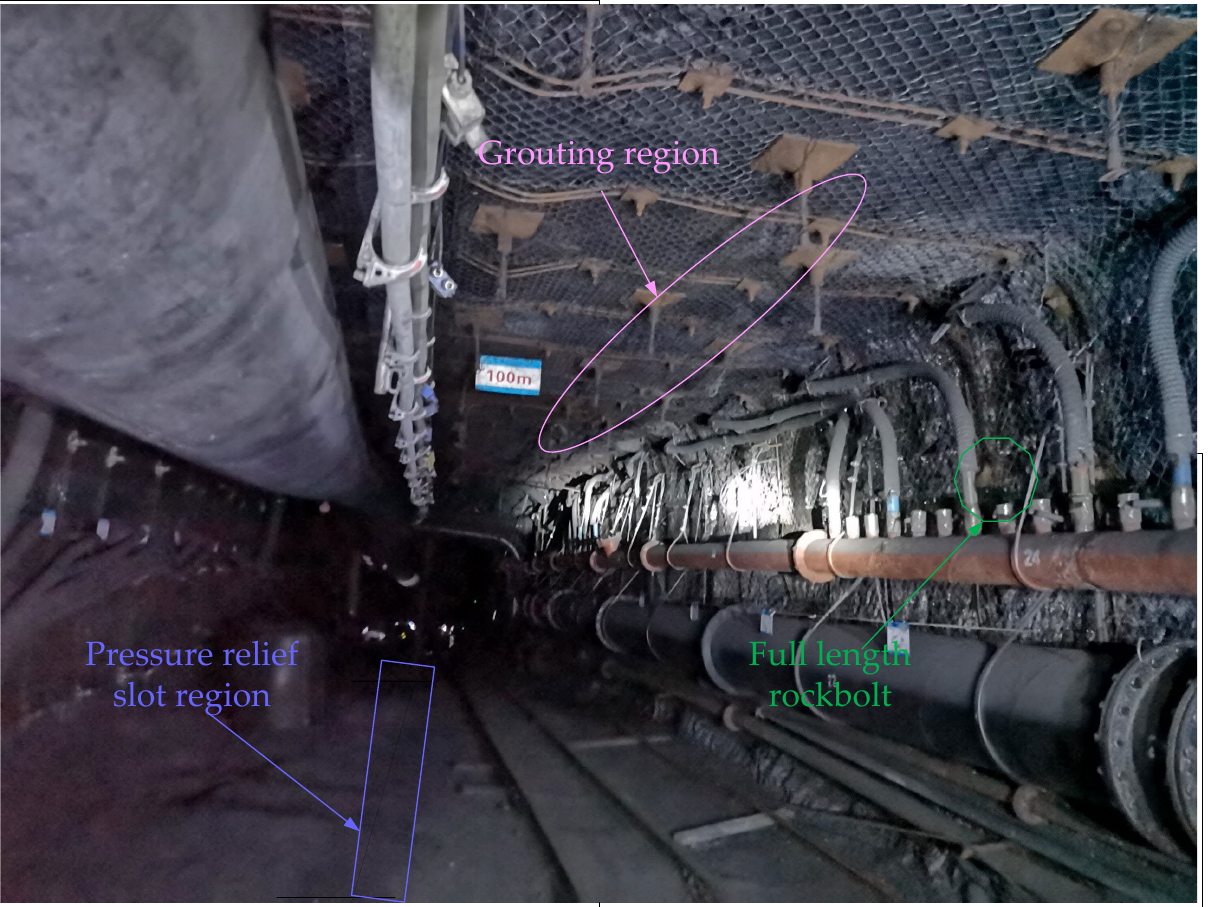
Figure 19. Field applications.